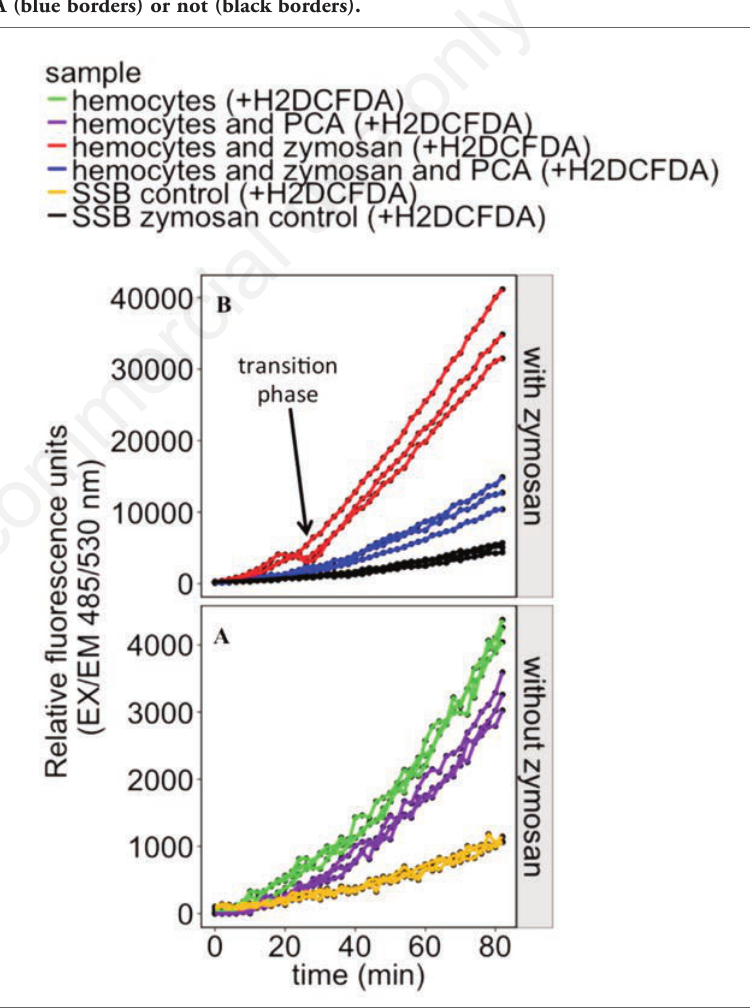
Figure 2. Example of kinetics of hemocyte-related oxidative activities from 25 µ L of hemolymph [gain=130]. The graph represents an example of the ROS kinetics obtained from raw data with the spectrofluorimeter into the different ex vivo conditions, for one snail, with corresponding controls. The black arrow indicates a kinetic transition ( i.e. , unknown phenomenon) being observed in most of the snails. Note that the scale from graph B is ten times bigger than the one from the graph A (values are much higher with zymosan particles and